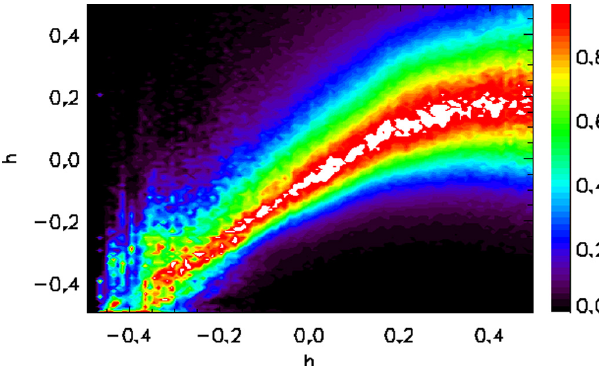
Fig. 4. Histograms of h SSS conditioned by h SST as derived from OFES simulation for the whole globe on 1 January 1990. For each column of the histogram the value of the SST-related variable is fixed, so the values in that column represent the distribution of pro- bability of values of the SSS-related variable for that fixed value of the SST-related variable. To enhance visualization, in this figure the histogram is normalized by its maximum probability in each row (so the brightest colour in each row represents the mode or maximum of probability along that row).